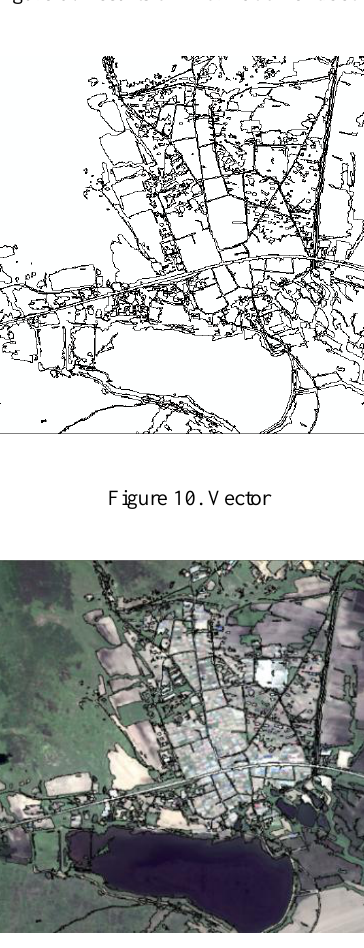
Figure 11. Vector with the original image